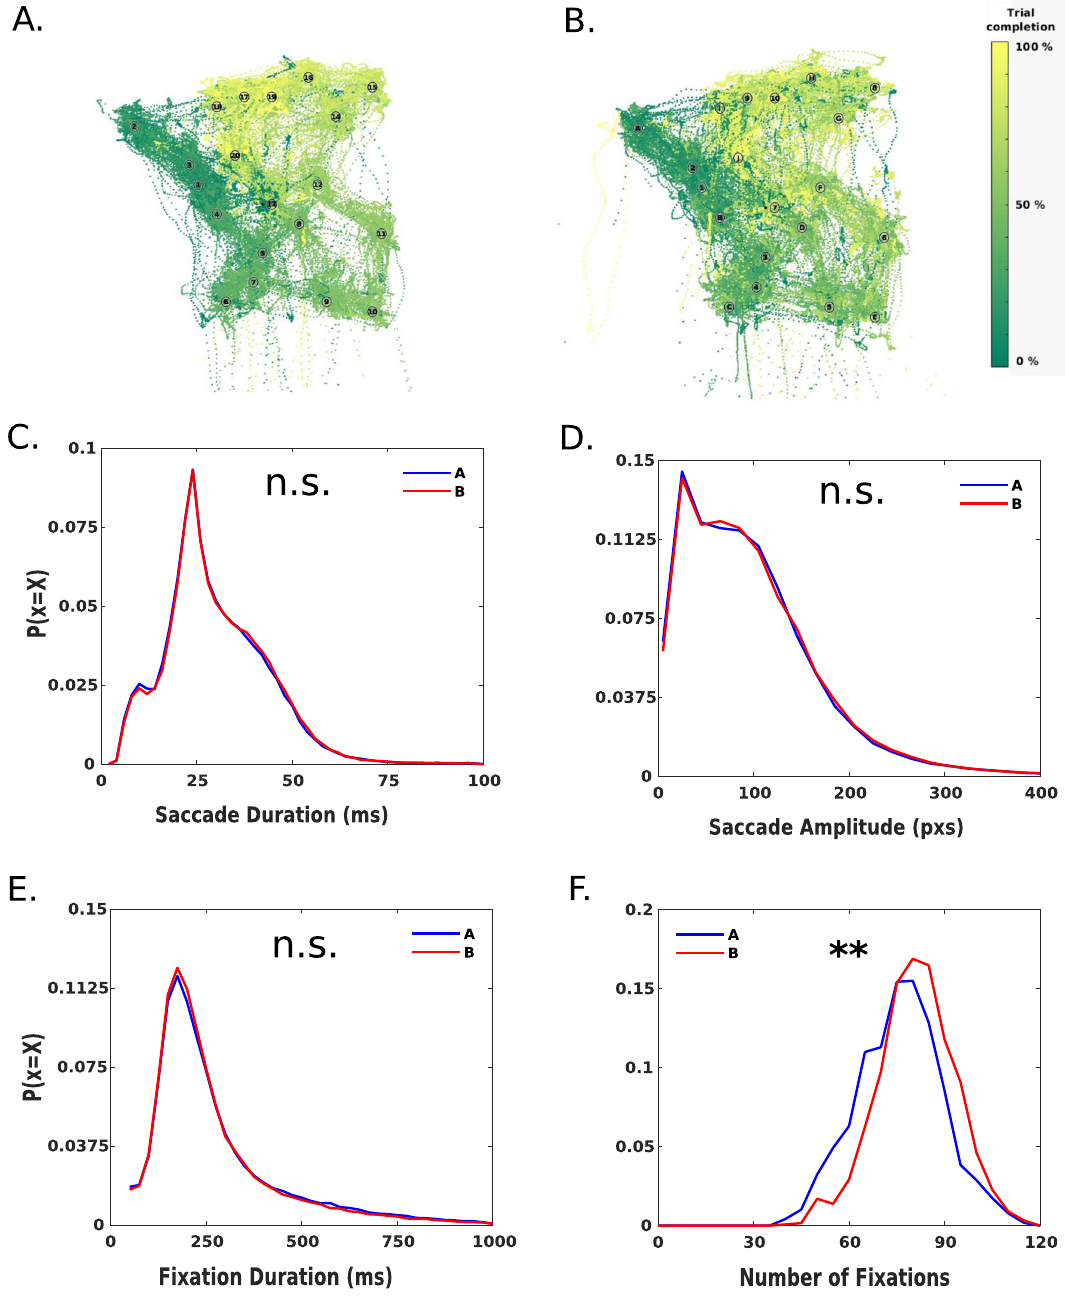
Figure 2. ( A,B ) Eye trajectory for all the subjects in a TMT-A ( A ) and TMT-B ( B ) trials. The colour bar represents the relative temporal evolution for each subject. Note that the yellow colour, representing the final fixations of the trial, are more consistently located around the last targets. ( C–F ) Individual eye movements characteristics. Distributions of saccade duration ( C ), saccade amplitude ( D ), fixation durations ( E ), and the number of fixations during the trial ( F ). Statistical significance of the difference between distributions was assessed with the Kuiper’s test: C: V = 0.01, p = 0.77; D: V = 0.01, p = 0.96; E: V = 0.02, p = 0.11; F: V = 0.17, p =